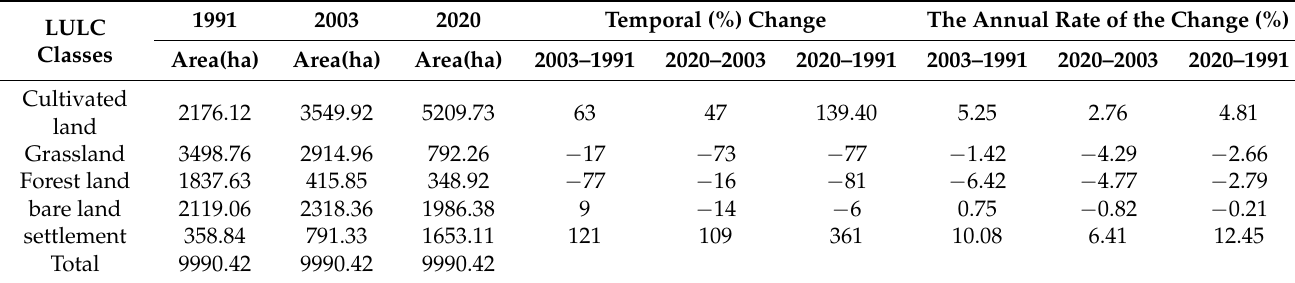
Table 5. Temporal and spatial rate of change LULC from 1991 to